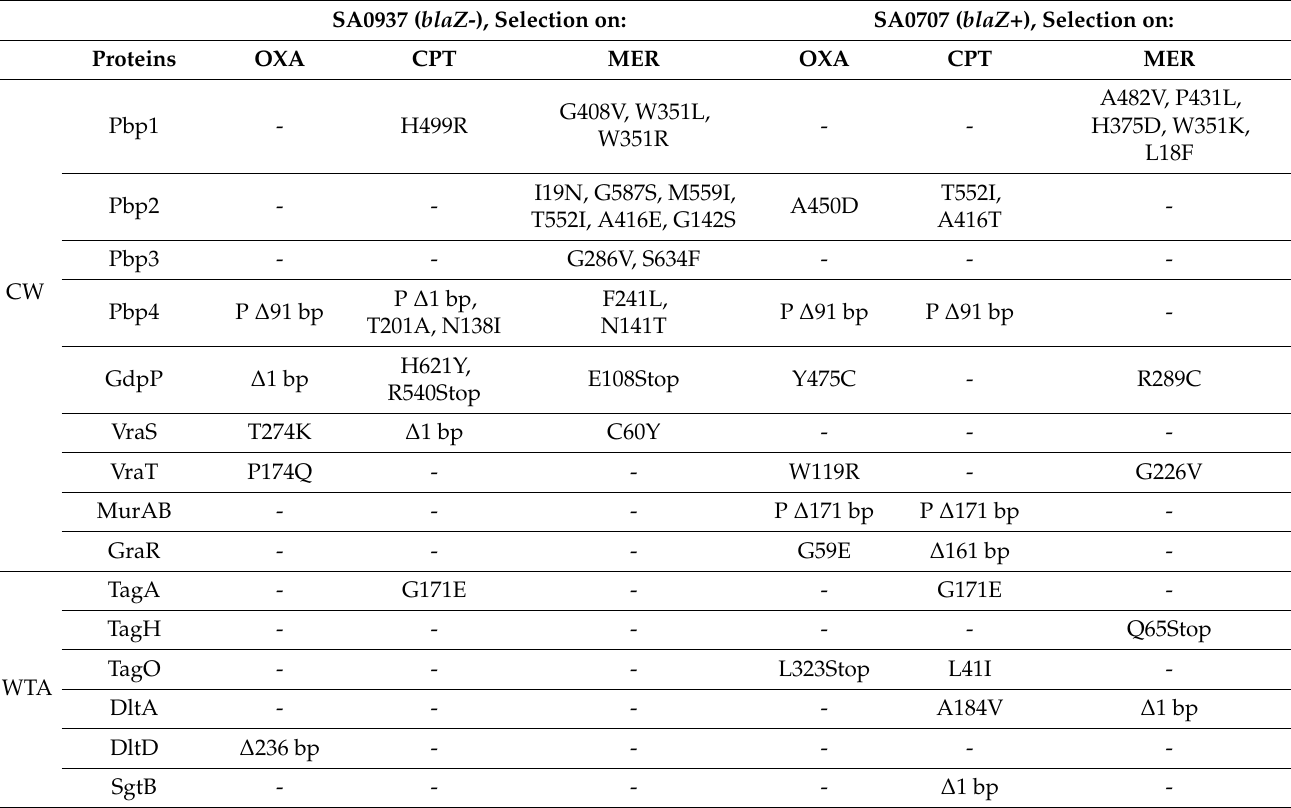
All mutations detected at different time points during selection and included minor mutations with allele frequency in range 10–95% are shown. P ∆ -deletion in promoter regions, ∆ -deletion in coding region; CW, genes involved in cell wall biosynthesis; WTA, genes involved in wall teichoic acids